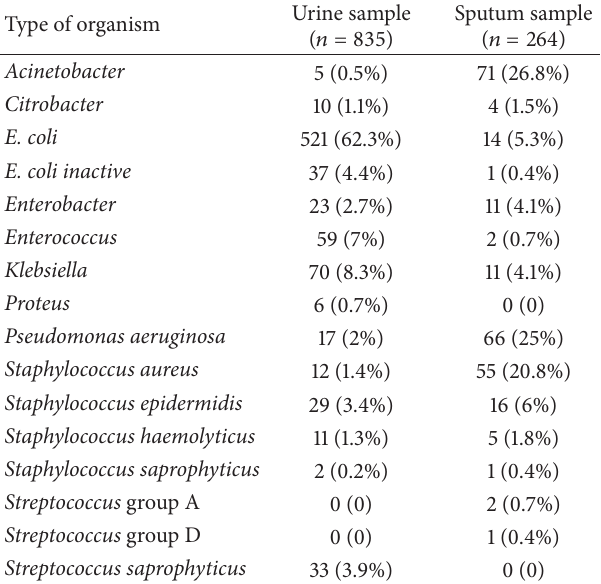
Table 2: Discriminative prevalence of isolated